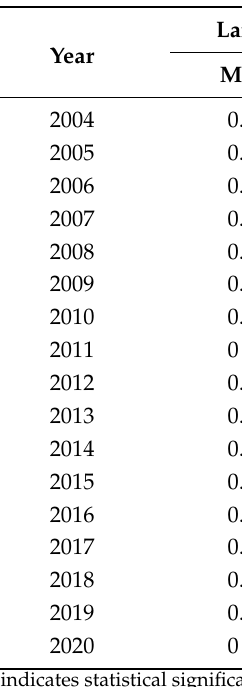
Table 3. Results of global Moran’s I